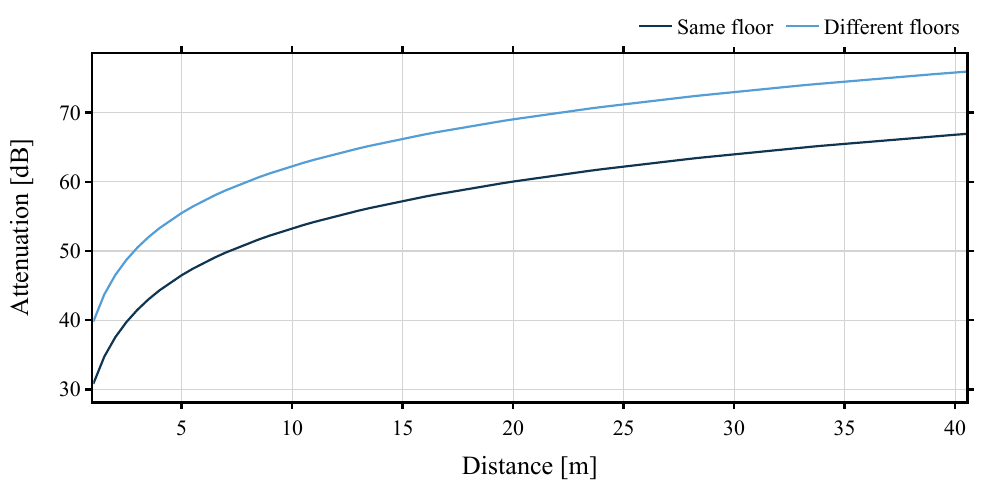
Figure 5. Theoretical attenuation over a distance up to